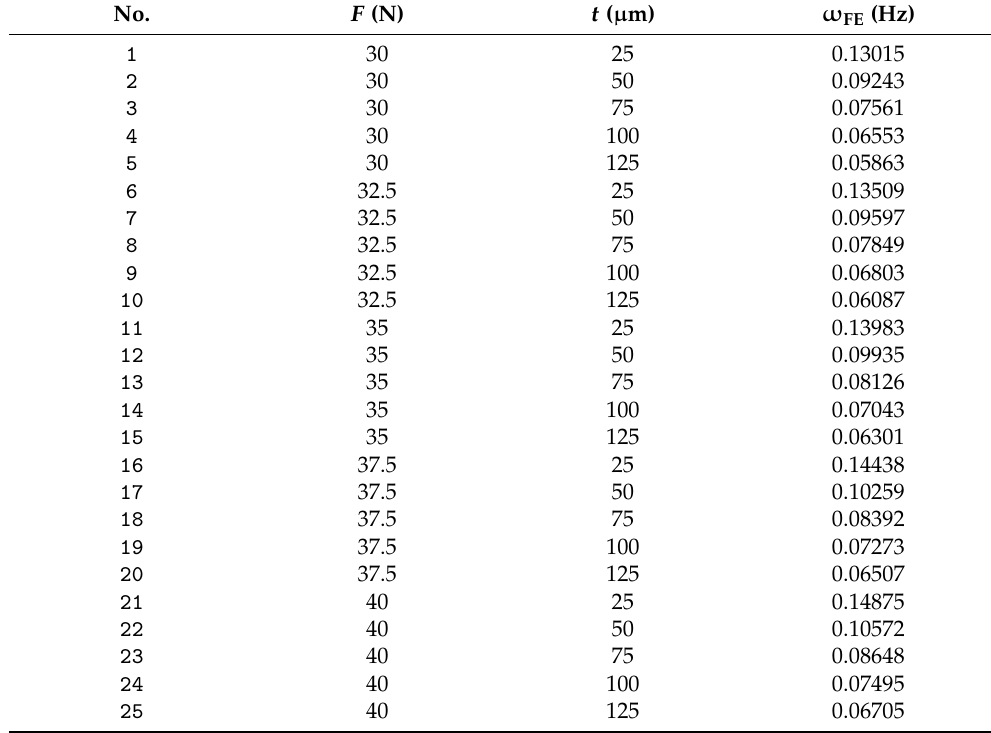
Table 4. FE results of the sample